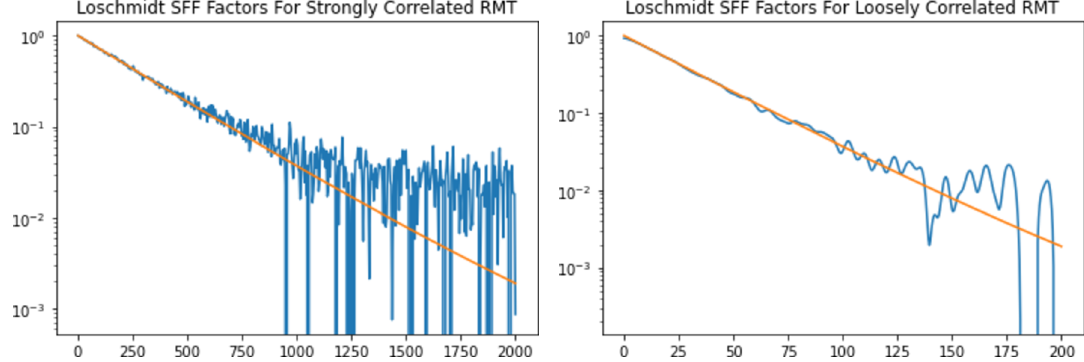
Figure 4 . Loschmidt SFF divided by the SFF, numerical results (blue) vs prediction (orange). The first graph is for a sample of 1320 pairs of 1500 by 1500 GUE matrices with correlated entries at r = . 998 . The second graph is for a sample of 10830 pairs of 300 by 300 GUE matrices correlated with r = . 98 .